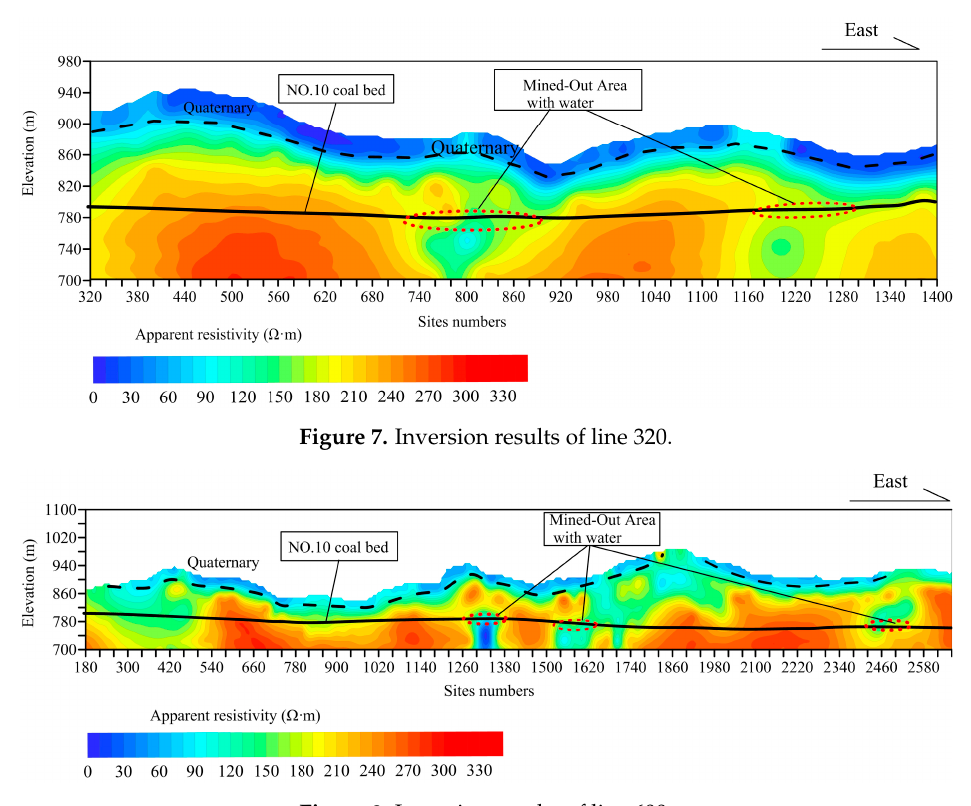
Figure 8. Inversion results of line